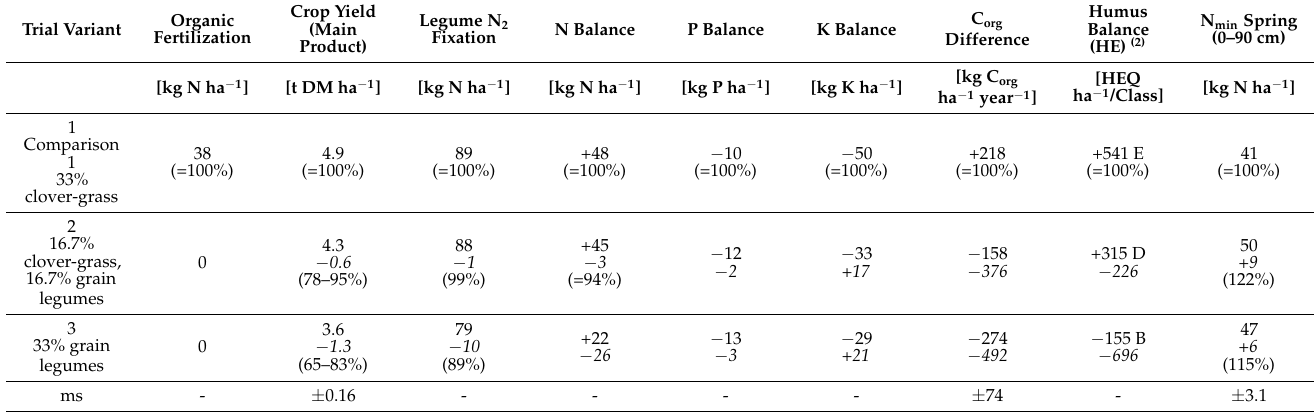
Table 5. Mean values, absolute (italics) and relative change (in parentheses) compared to a mean intensity [=100%, see Table 2], and supply classes (1) of important characteristics of fertilization and soil fertility in market crop systems with 33% rotation share of legumes from clover-grass or grain legumes, respectively, in long-term trials on loamy